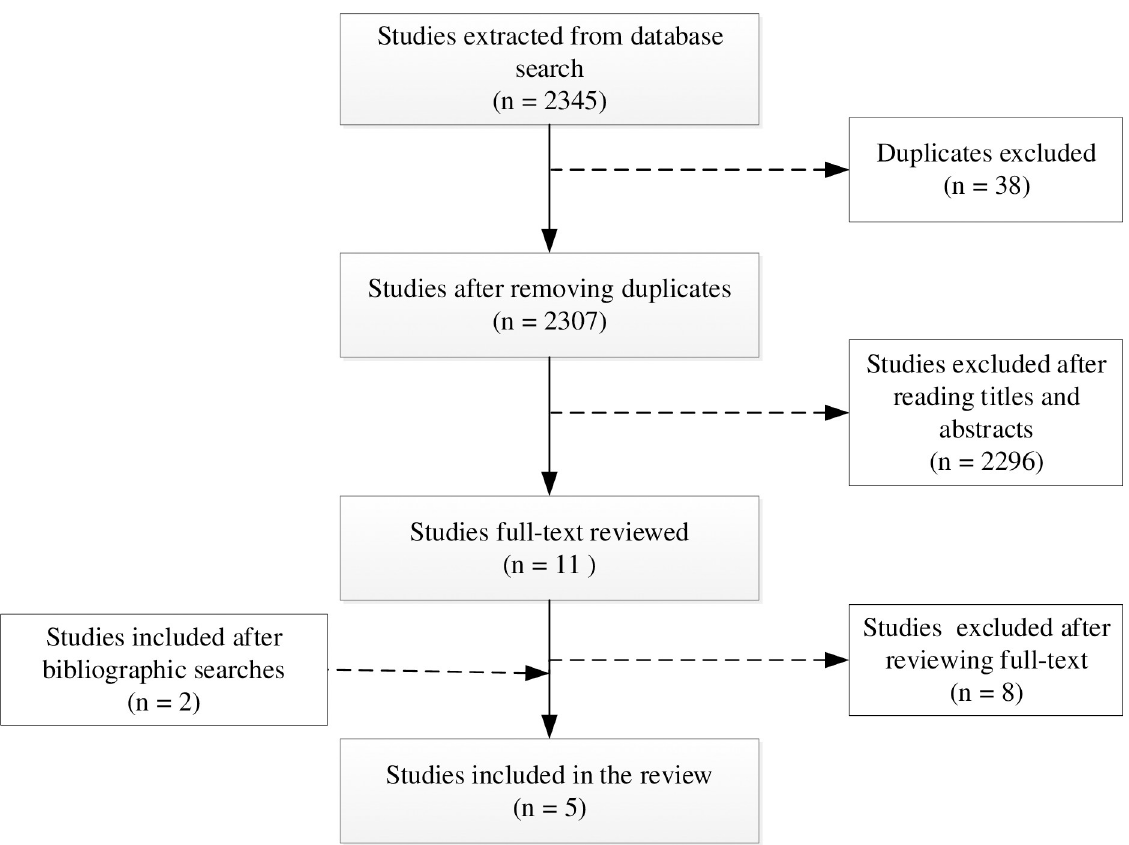
Fig 1. PRISMA flowchart for the selection of eligible